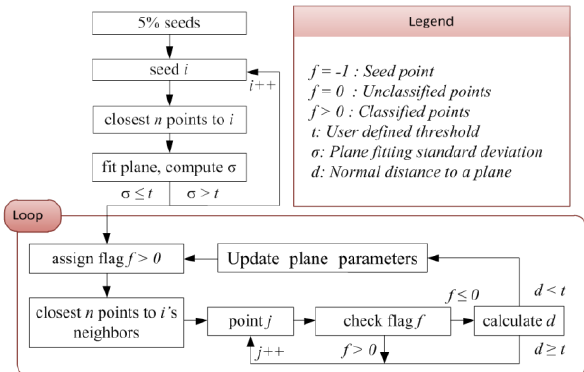
Figure 2: A flowchart summarizing the data characterization procedure.